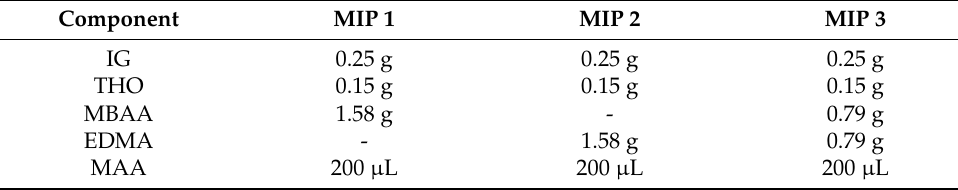
Table 3. Comparison of the three different MIPs used in this